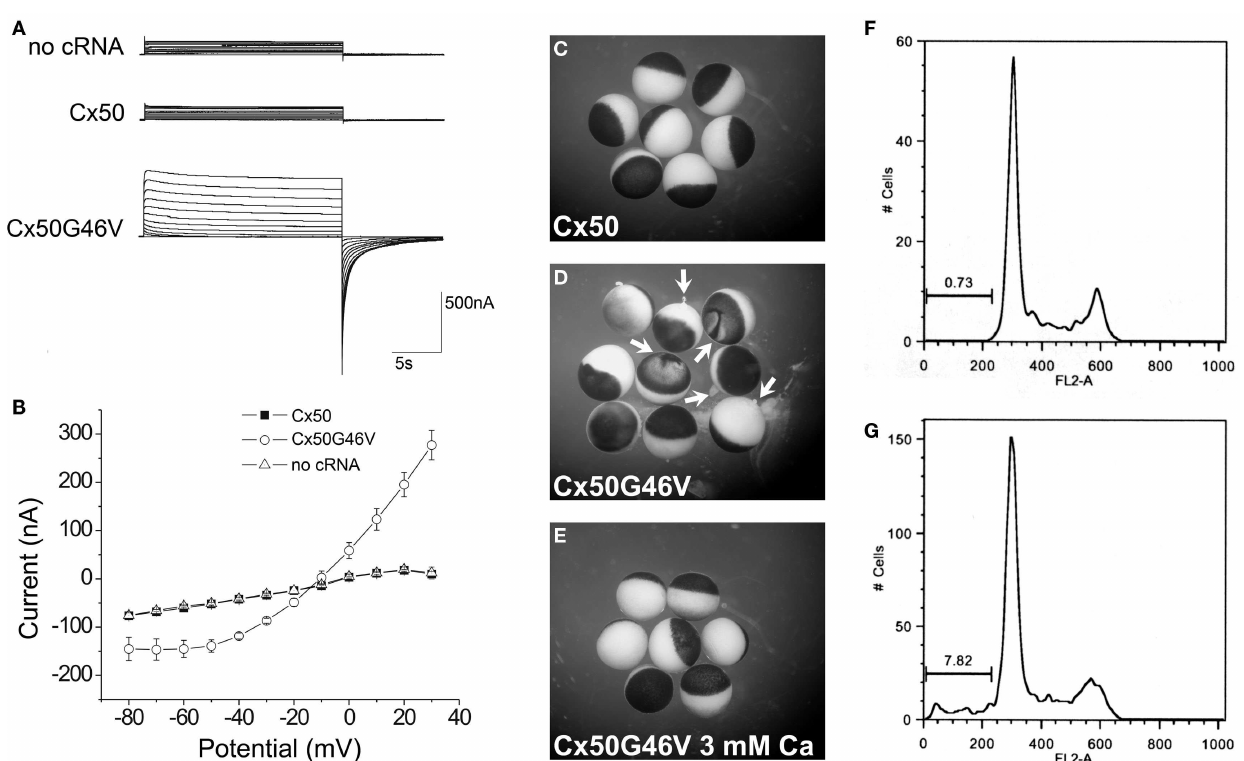
FIGURE 6 |The Cx50G46V mutant induces large hemichannel currents, cytotoxicity, and apoptosis. (A) Hemichannel currents elicited in response to a series of voltage pulses in control Xenopus oocytes (no cRNA) or oocytes injected with cRNA encoding wild type Cx50 or Cx50G46V.The mutant induces much larger currents than wild type Cx50 or control oocytes. (B) Steady-state current-voltage relationships in control (no cRNA), wild type Cx50, and Cx50G46V cRNA-injected oocytes.The mutant induces large outward currents that activate on depolarization. (C–E) Xenopus oocytes were injected with similar amounts of Cx50 ( C ) or Cx50G46V cRNA (D,E) and incubated in modified Barth’s solution containing 1mM Ca 2 + (C,D) or 3mM Ca 2 + (E) overnight at 18˚C. Oocytes injected with Cx50G46V cRNA showed obvious discoloration, membrane disruption, and leakage of yolk